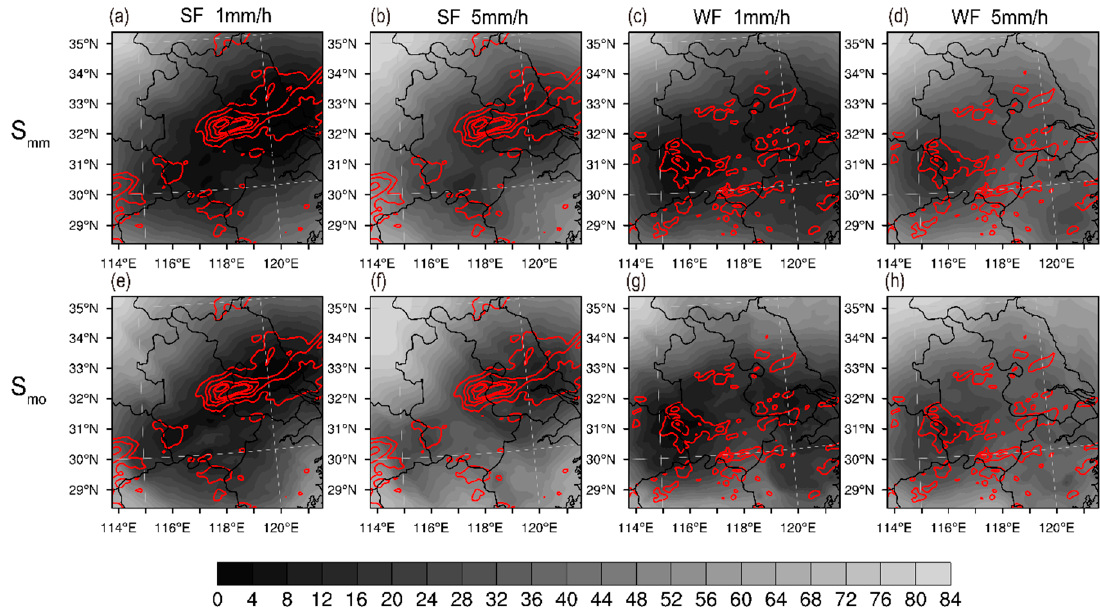
Figure 4. Case-averaged spatial distribution of ( a – d ) S mm and ( e – h ) S mo averaged over the 1–12 h lead time for ( a , b , e , f ) SF events and ( c , d , g , h ) WF events, with precipitation thresholds of ( a , c , e , g ) 1 mm / h and ( b , d , f , h ) 5 mm / h. The red contours show the case-averaged 12 h accumulated precipitation which is indicative of moist areas.